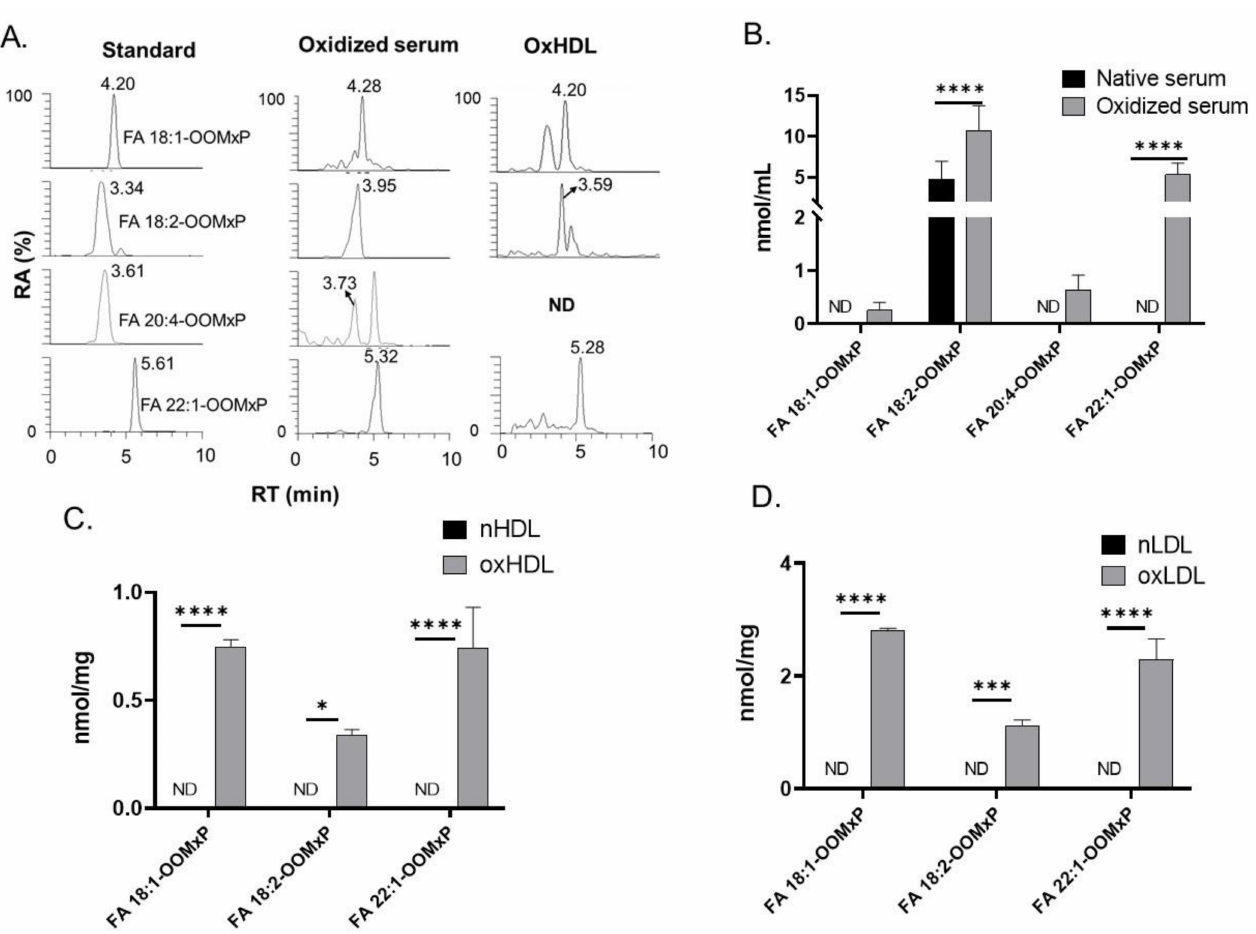
Figure 4. Quantitation of total FAOOHs in human serum and lipoproteins. ( A ) Extracted ion chromatograms of standard and those detected in samples. ( B ) Detected FAOOHs in native and oxidized human serum ( n = 5). ( C ) Amount of FAOOHs detected in native LDL (nLDL) and oxidized LDL (oxLDL) ( n = 4). ( D ) Amount of FAOOHs detected in native HDL (nHDL) and oxidized HDL (oxHDL) ( n = 4). Two-way ANOVA with Tukey multiple comparison tests were applied and p < 0.05 was considered to be statistically significant (ND: not detected, p = 0.0332 (*), 0.0002 (***), 0.0001